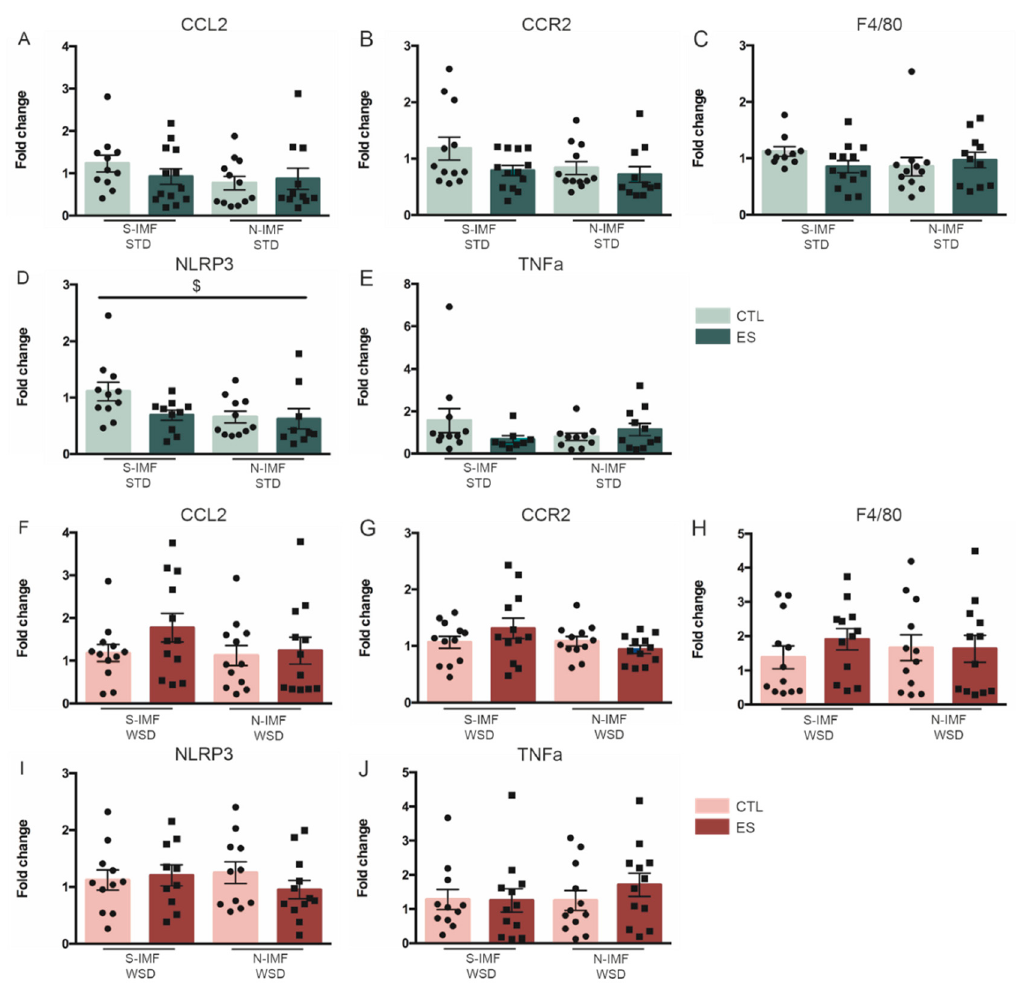
Figure 7. Effects of ES and postnatal diet on expression of inflammatory genes in adulthood, after either STD ( A – E ) or WSD ( F – J ). ( A , B , C , E ) ES nor postnatal diet affected adipose tissue gene expression of CCL2, CCR2, F4/80 or TNF α in adulthood when fed STD. ( D ) Postnatal N-IMF diet decreased NLRP3 expression at P230, when fed STD in adulthood. ( F – J ) ES and postnatal diet did not affect expression of CCL2, CCR2, F4/80, NLRP3 and TNF α in the adipose tissue when fed WSD in adulthood. Data are presented as mean ± SEM; $ diet effect; p < 0.05.